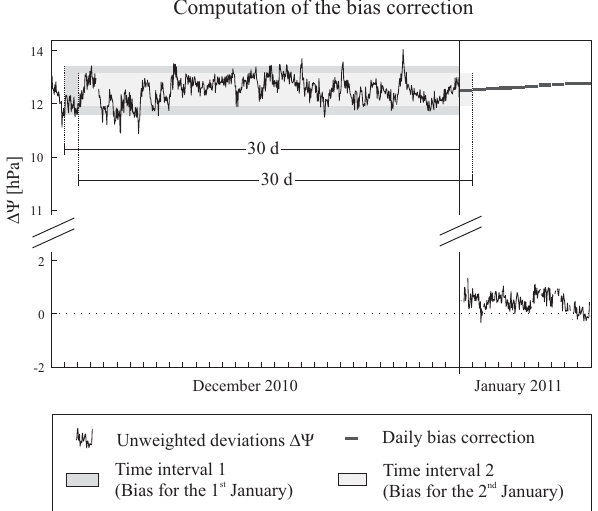
Fig. 7. Example spatial distribution of the bias corrections > 5hPa for MSL-pressure, valid for 31 July 2010 within the European do- main. Circles symbolize negative bias corrections, and squares mark positive ones. In most cases, these can be explained by reduction er- rors (e.g. due to wrong station